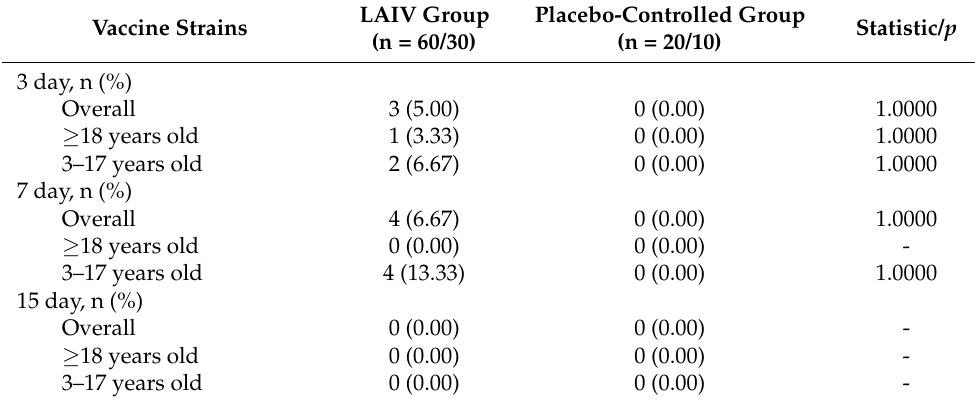
Table 5. Viral shedding of subjects.